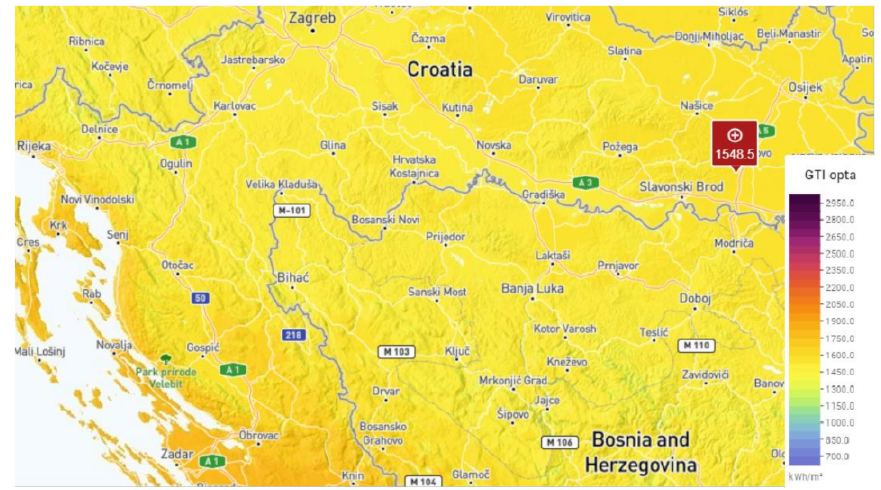
Figure 1. Global tilted irradiation at the optimum angle for Dragotin [24].